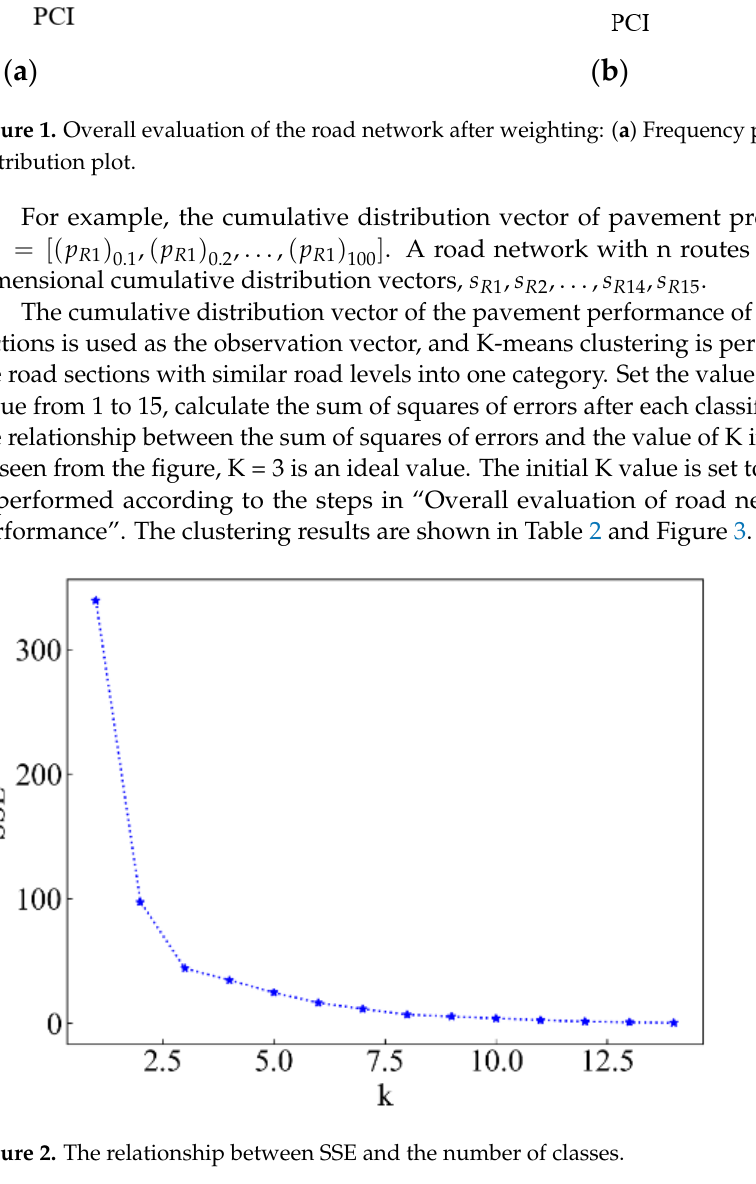
E 8 Figure 3. Clustering diagram obtained by using K-means algorithm based on road performance distribution of road sections (K = 3). Analyzing Figure 3, the 15 routes are divided into three categories according to the level of pavement performance. Class III includes only one route, R11, and is the class with the worst road performance level.